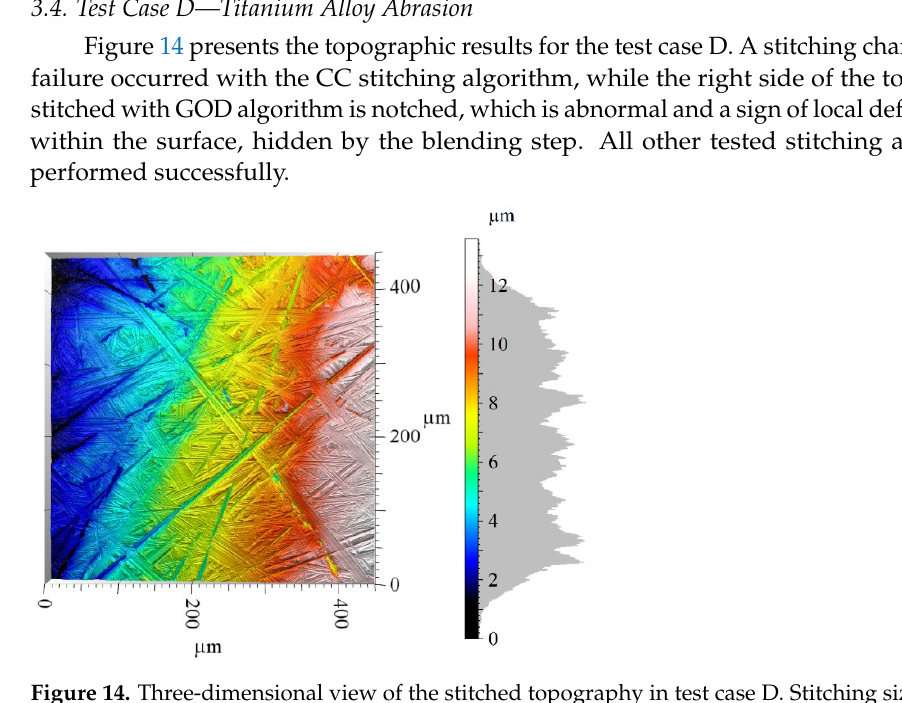
Figure 14. Three-dimensional view of the stitched topography in test case D. Stitching size: 10 × 13.